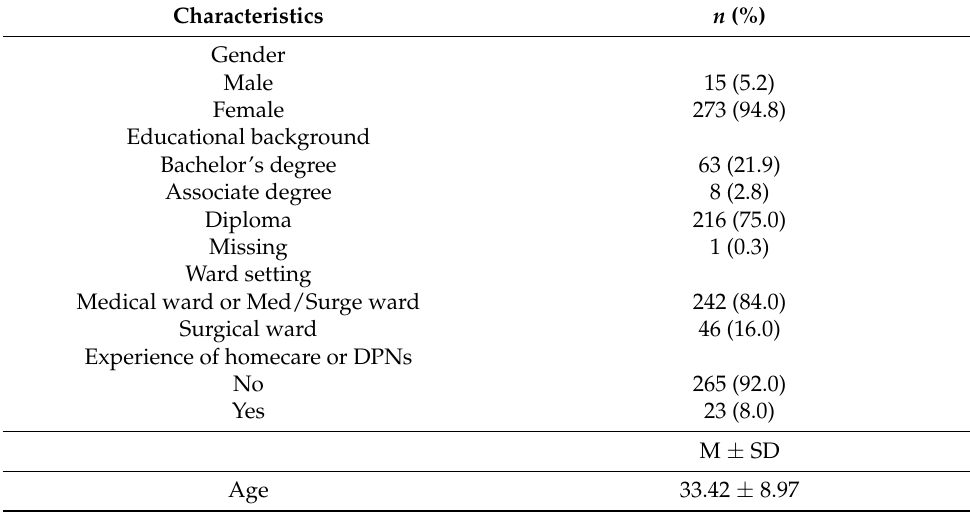
Table 1. Participants’ characteristics (N = 288).